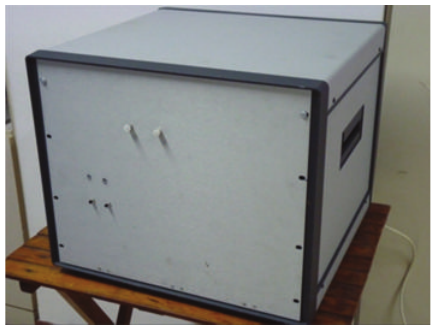
Figure 1: Portable prototype for SBS-based distributed strain and temperature